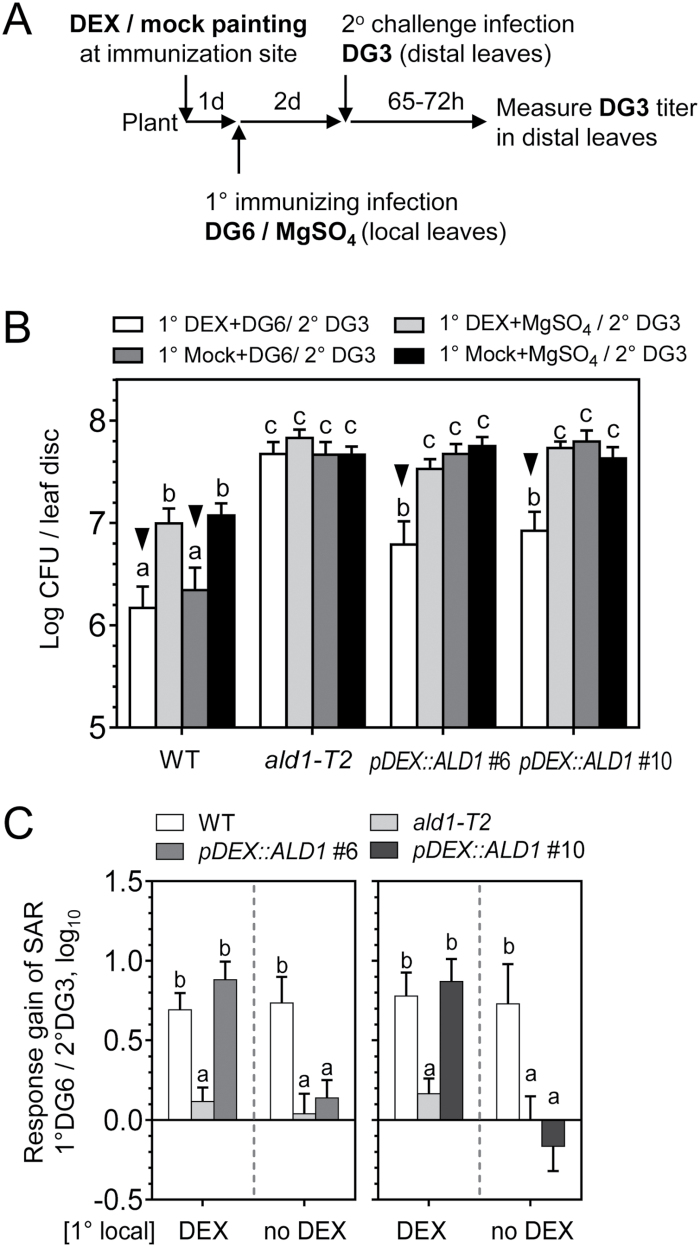
Specific expression of ALD1 at the immunization site restores SAR in distal leaves. (A) Treatment schemes for specific expression of ALD1 at the immunization site during SAR establishment. Typically, local leaves (1°, the third to fifth leaves) were painted with 15–30 μM DEX or mock solution prior to SAR-triggering primary infection of an avirulent strain PmaDG6 (DG6, OD600=0.01) or 10 mM MgSO4. Then distal leaves (2°, the sixth to eighth leaves) without DEX treatment were inoculated with a virulent PmaDG3 (DG3, OD600=0.0002) for the secondary infection. The quantification of DG3 growth in distal leaves was determined ~65–72 h later. (B) Titer of DG3 in distal leaves of the indicated genotypes. The number of colony-forming units (CFUs) of DG3 was measured in distal leaves. Error bars indicate the SEM of eight biological replicates (from eight plants). The result is representative of five independent experiments with similar results. Black triangles indicate SAR establishment under the corresponding treatment conditions. (C) Response gain of SAR associated with immunizing infection by 1° DG6 in local leaves with or without DEX treatment. Data for the line pDEX::ALD1 #6 (left panel) are the average of 2–3 experiments (DEX, three times; no DEX, twice), while data for the line pDEX::ALD1 line #10 (right panel) are the average of 1–2 experiments (DEX, twice; no DEX, once). Error bars indicate average uncertainties from the indicated experiments. Different letters indicate statistically significant differences (P<0.05, ANOVA, Fisher’s LSD test).